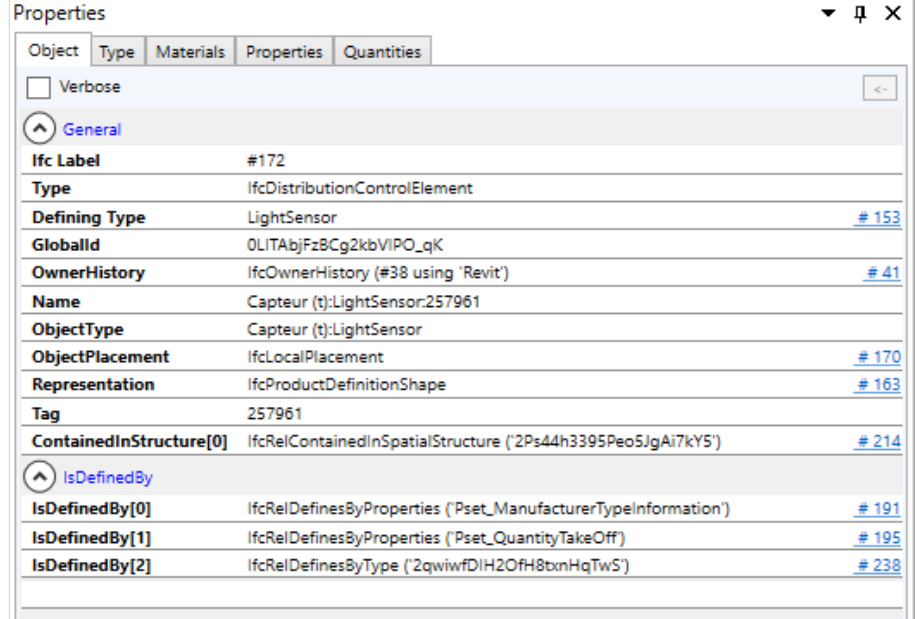
Figure 6. Representation and export of semantic data to XbimXplorer in IfcBuildingElementProxy (first prototype), and using the family and type for reference (second prototype). 5.2.3. Second Prototype—Using ‘Object Types’